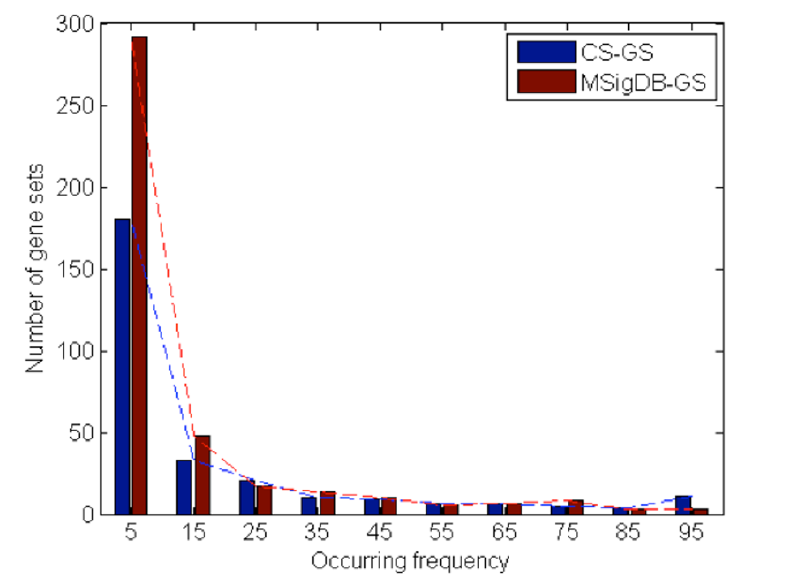
Figure 4: Occurring frequency distributions for the top 50 most significant gene sets. Dashed lines indicate the fitted